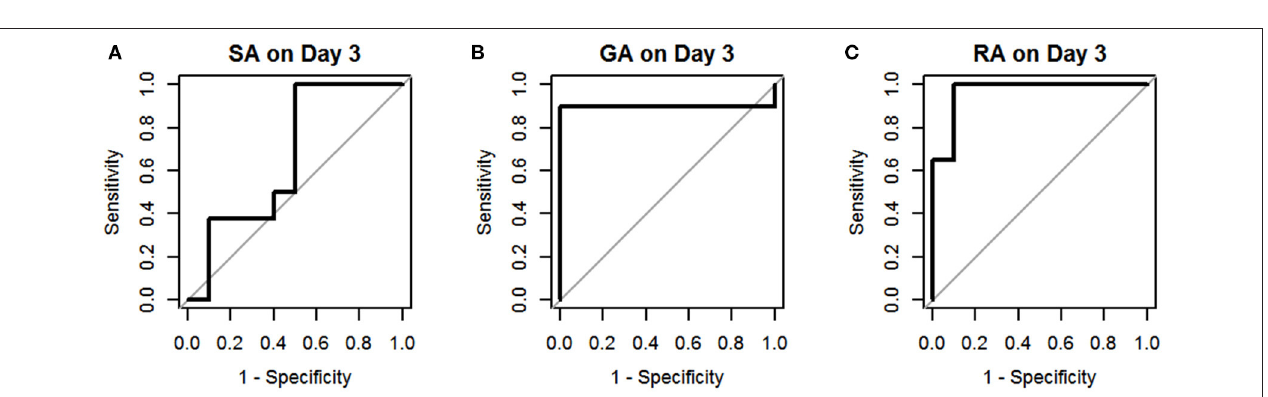
FIGURE 3 | Receiver operating characteristic curves for sCD40L in distinguishing children with acute appendicitis from NA on day 3: SA (A) , GA (B) , and RA (C) .